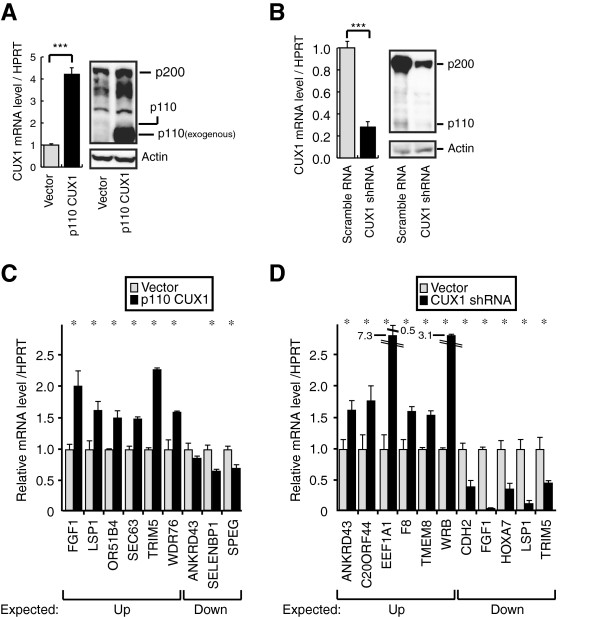
Overexpression and Knockdown of CUX1 and Expression Profiling
Validation. (A) Hs578t cells were infected with a
lentiviral vector expressing p110 CUX1 or nothing (vector). RNA and
proteins were purified 48 hours post-infection. CUX1 expression was
analyzed by RT-qPCR and immunoblotting. (B) Hs578t cells were
infected with a lentiviral vector expressing CUX1 shRNA or a scrambled
RNA. RNA and proteins were purified 5 days after
infection. CUX1 expression was analyzed by and RT-qPCR and
immunoblotting. (C) RNA levels of the indicated genes were
measured by RT-qPCR in cells treated as in A. Expected up or down
indicates regulation that was observed by expression profiling.
(D) RNA levels of the indicated genes were measured by
RT-qPCR in cells treated as in B. Expected up or down indicates
regulation that was observed by expression profiling. * p<0.05, ***
p<0.001 on a Student's T test.